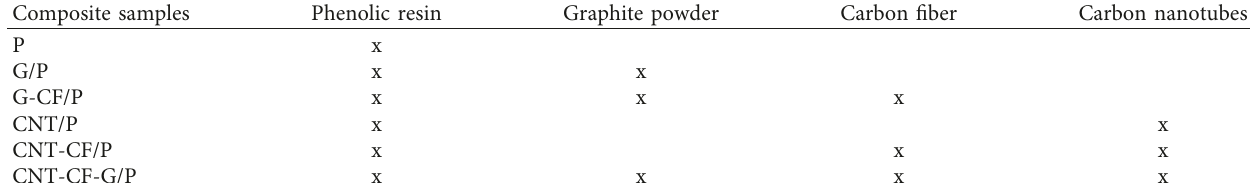
Table 1: Mix design of P, G/P, G-CF/P, CNT/P, CNT-CF/P, and CNT-CF-G/P composites.